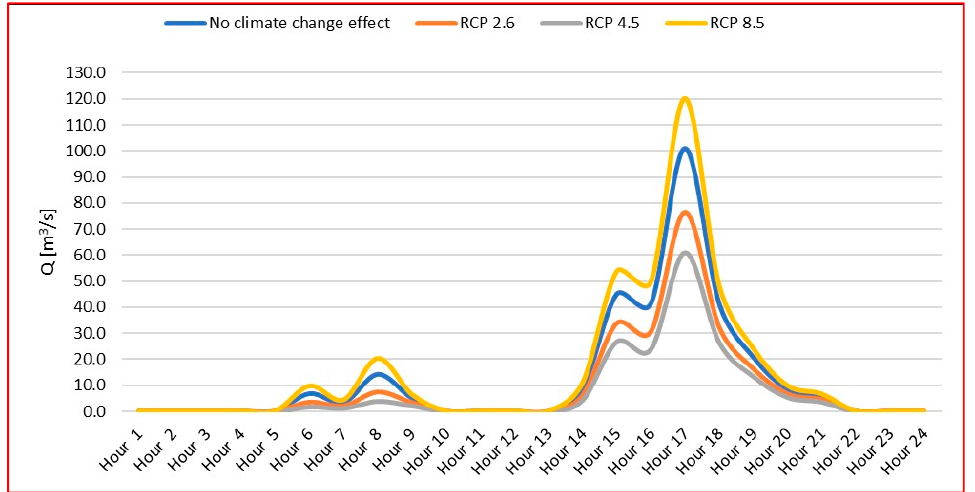
Figure 9. Simulated hydrographs (created using AMC II) at the outlet (4 September 2011 rainfall event): hydrograph with no climate change effect is reported together with the projections in the future climate (RCP 2.6, RCP 4.5 and RCP 8.5). Table 4. Peak flow rate (Q) and volume (V) and event runoff factor (R d ) for the various scenarios, considering the flood event generated by 4 September 2011 rainfall event and using AMC II to produce surface runoff at Sarnico station.